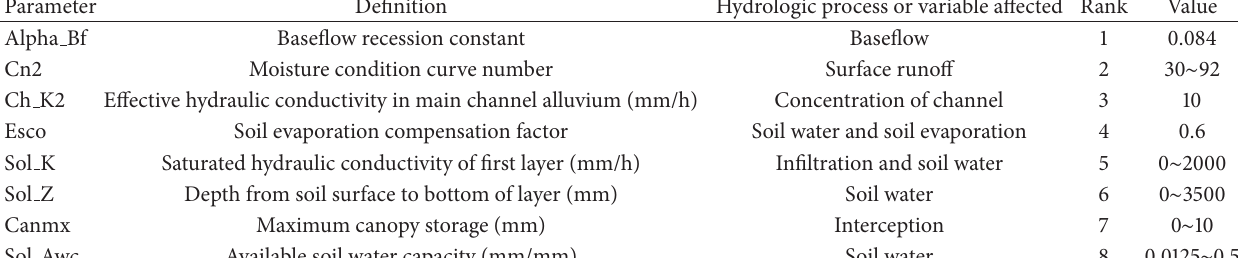
Table 4: The results of parameter sensitivity analysis and calibration.